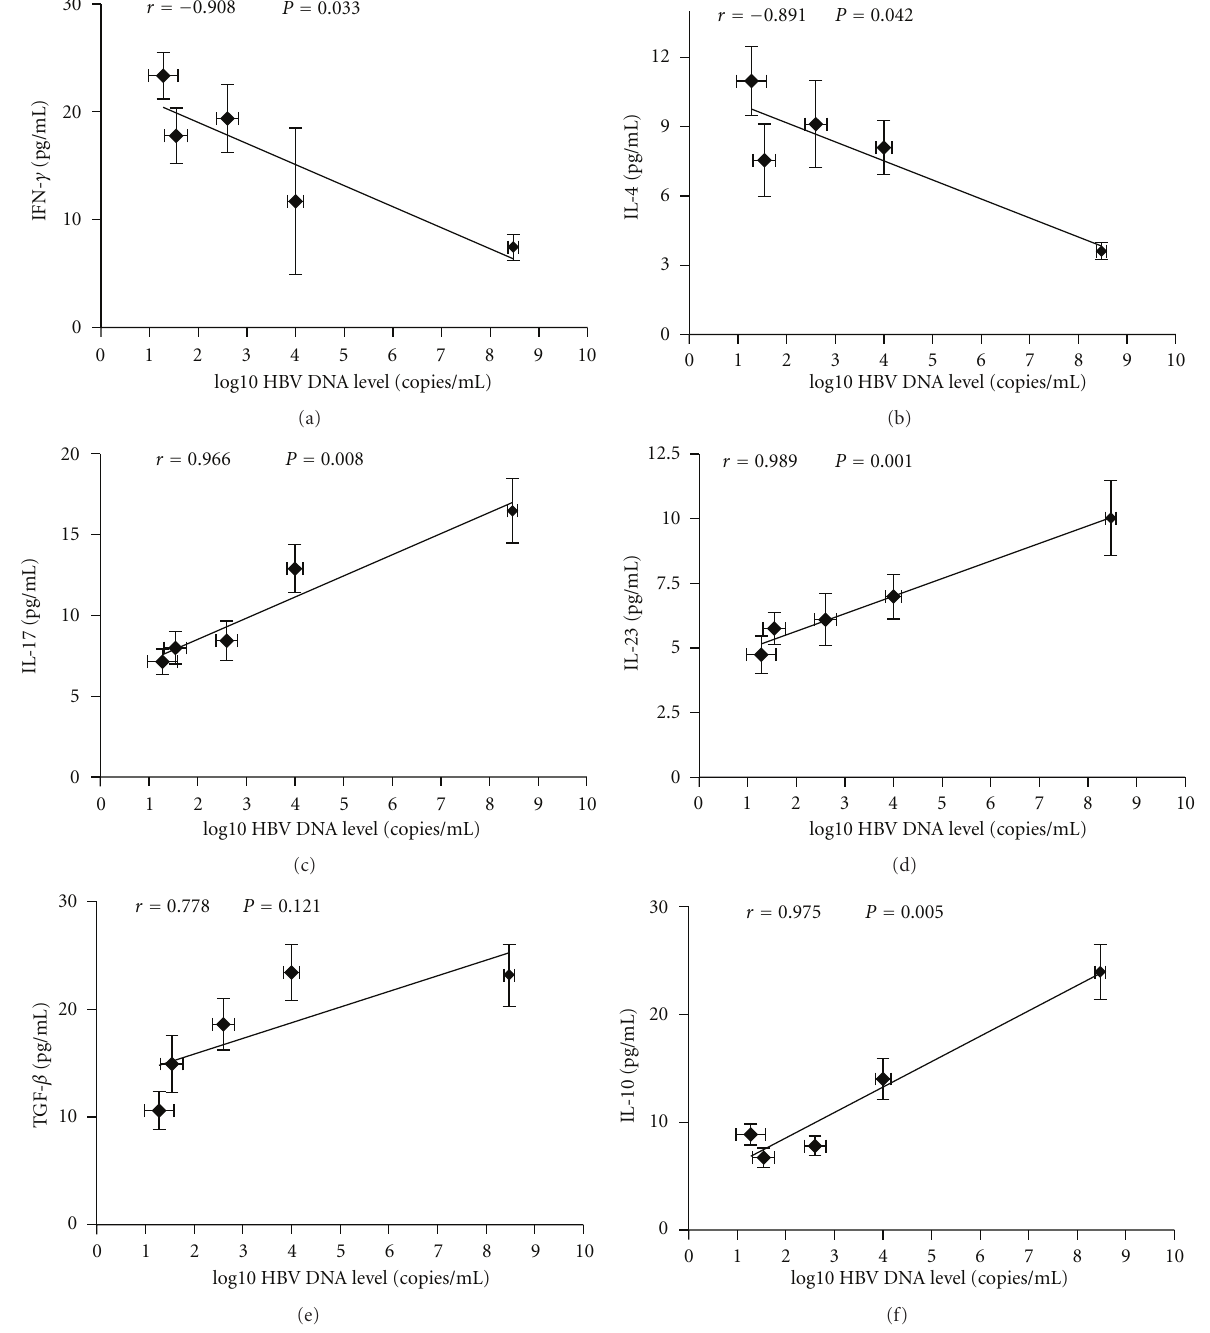
Figure 4: Correlation between the signature cytokines of CD4 + T-cell subtypes and HBV DNA level. Expression of the signature cytokines for each of the CD4 + T-cell subtypes and HBV DNA level at various time points of treatment (baseline and weeks 12, 24, 36, and 52) are indicated on the plots by diamonds. Error bars indicate